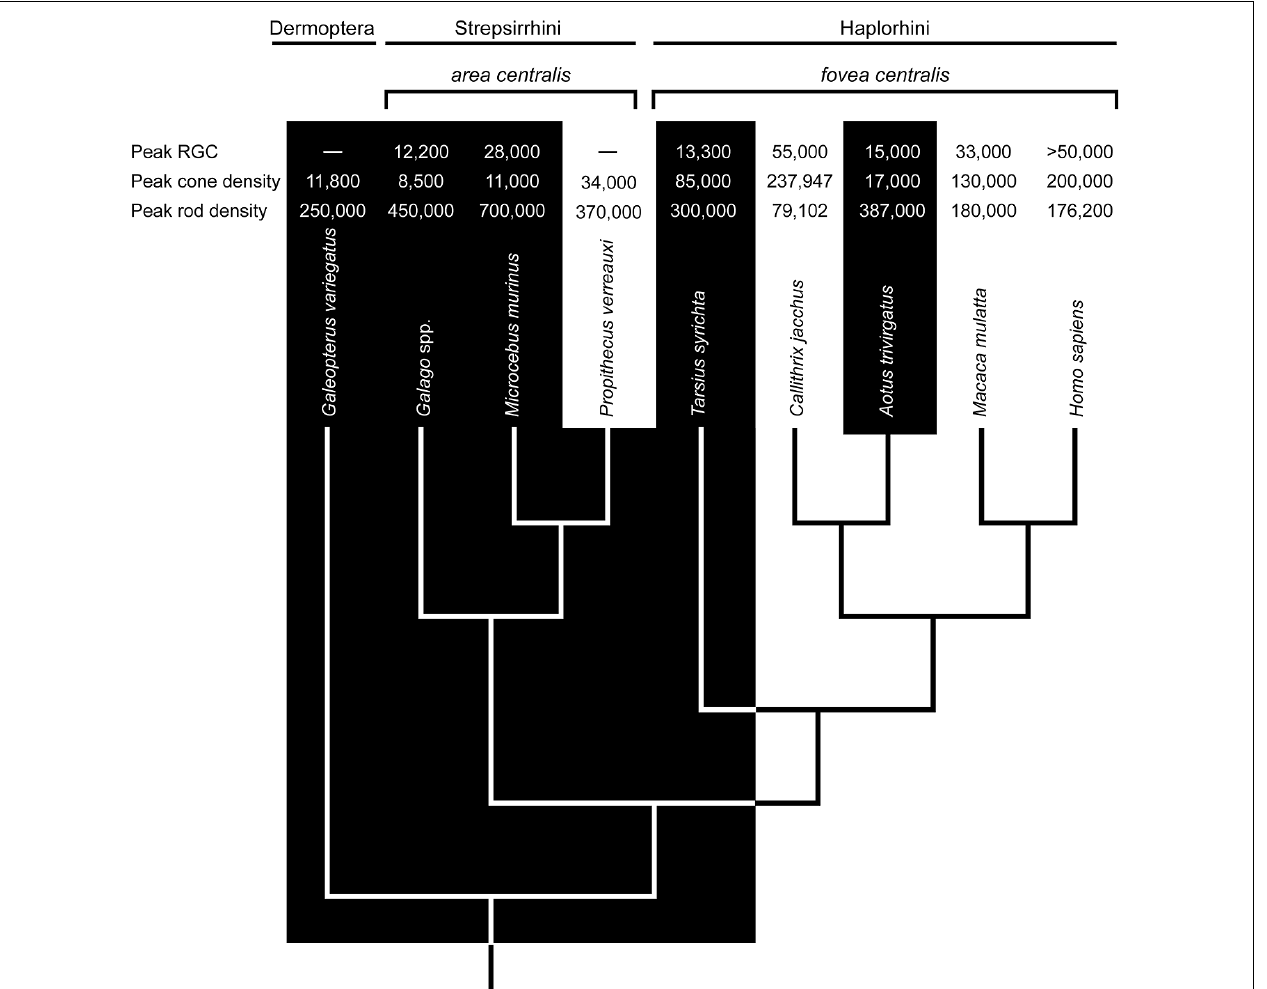
2001; Ross, 2004; Tetreault etal., 2004; Finlay etal., 2008; Moritz etal., 2013). Ancestral character states based in part on these values suggest a diurnal ancestry for Tarsius and Aotus ; and, by extension, stem anthropoids (e.g., Ross, 2000; Williams etal., 2010). Accordingly, the foveae of Tarsius and Aotus are most likely vestigial traits. A problem with this view is evident in the densities of RGCs, cones, and rods. Relative to Tarsius , the retina of Aotus has advanced further toward a nocturnal phenotype despite a substantially younger vintage of 5–20 million years (see